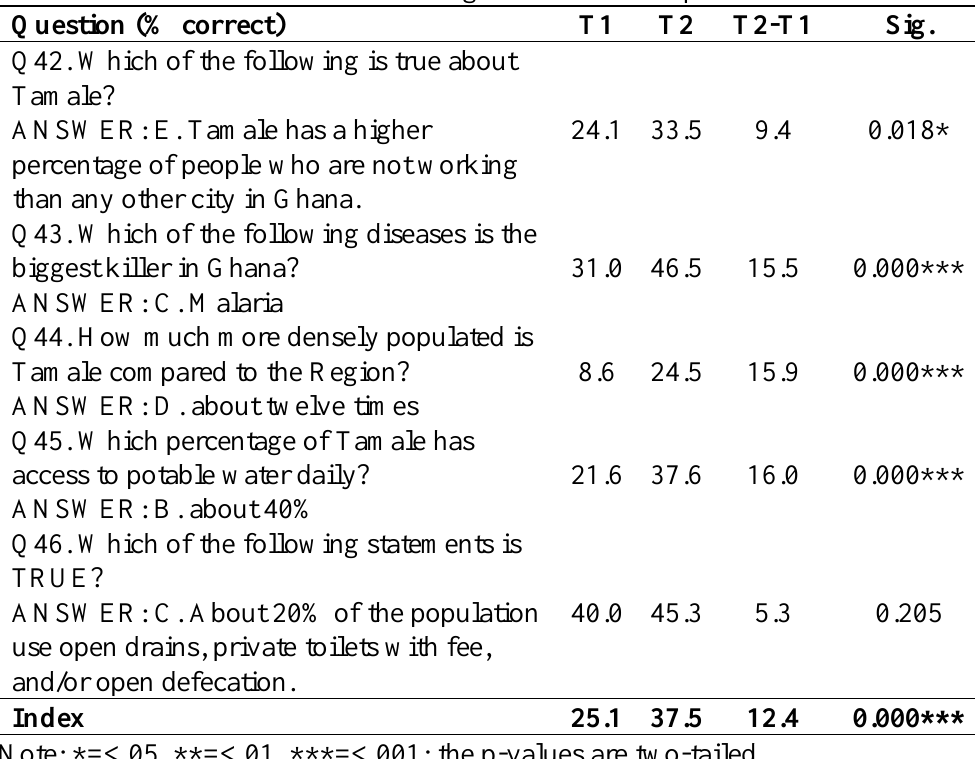
Table 2: Tamale Knowledge Changes – Pre and Post